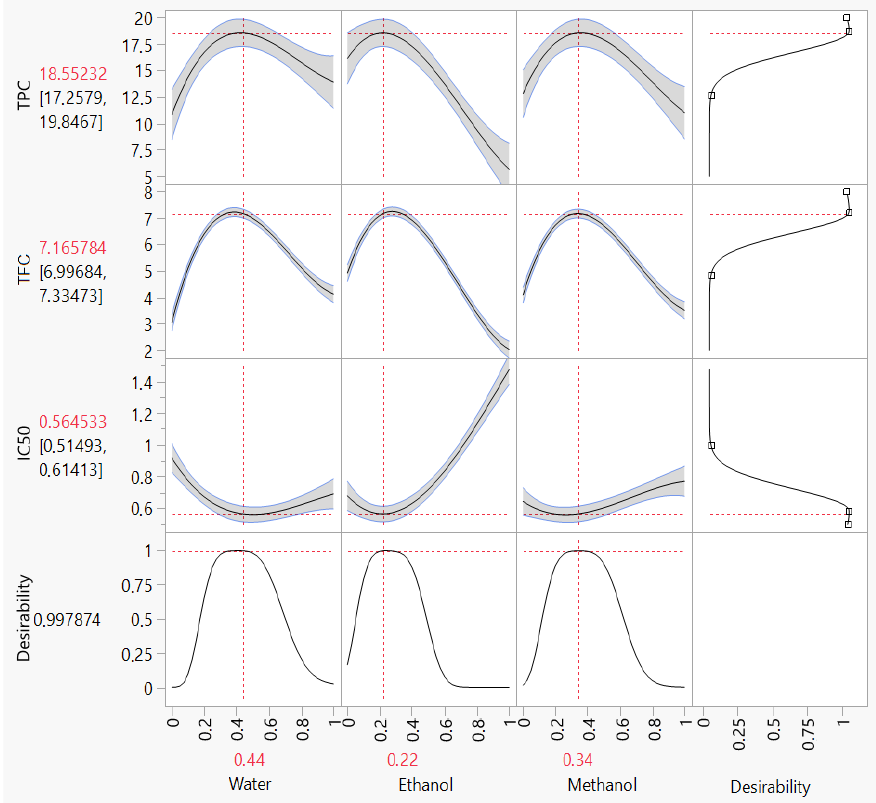
Figure 6. Desirability plots of simultaneous optimization demonstrating the maximum value of TPC, TFC and DPPH IC50 .